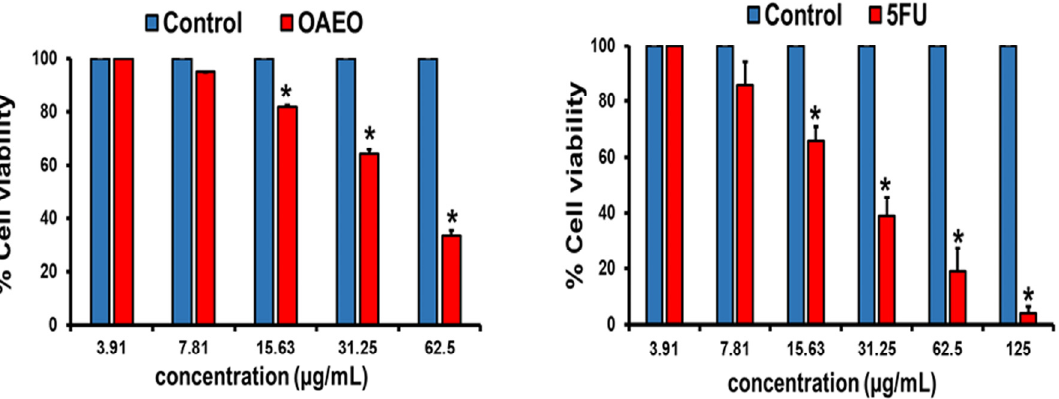
Figure 2. Inhibition of cell viability by OAEO and 5-FU in AGS cells, as determined by MTT assay. Data are presented as the mean ± standard deviation of three independent experiments. * p < 0.05 vs. control.